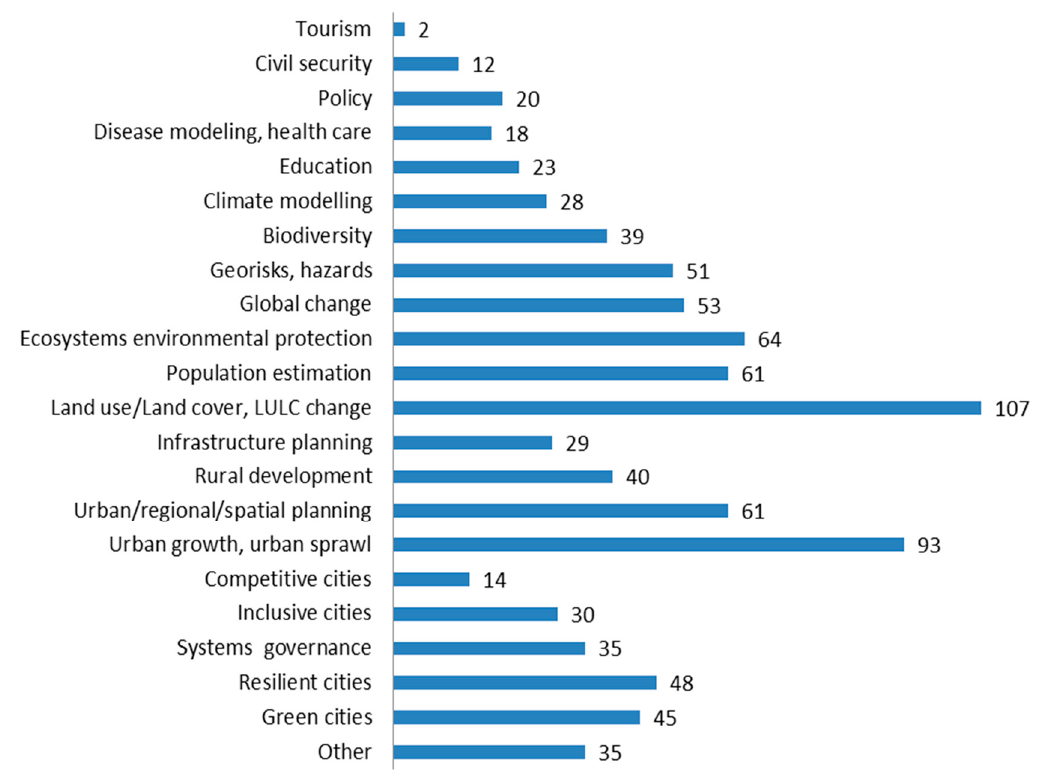
Figure 5. Fields of GUF application as indicated by the user community.